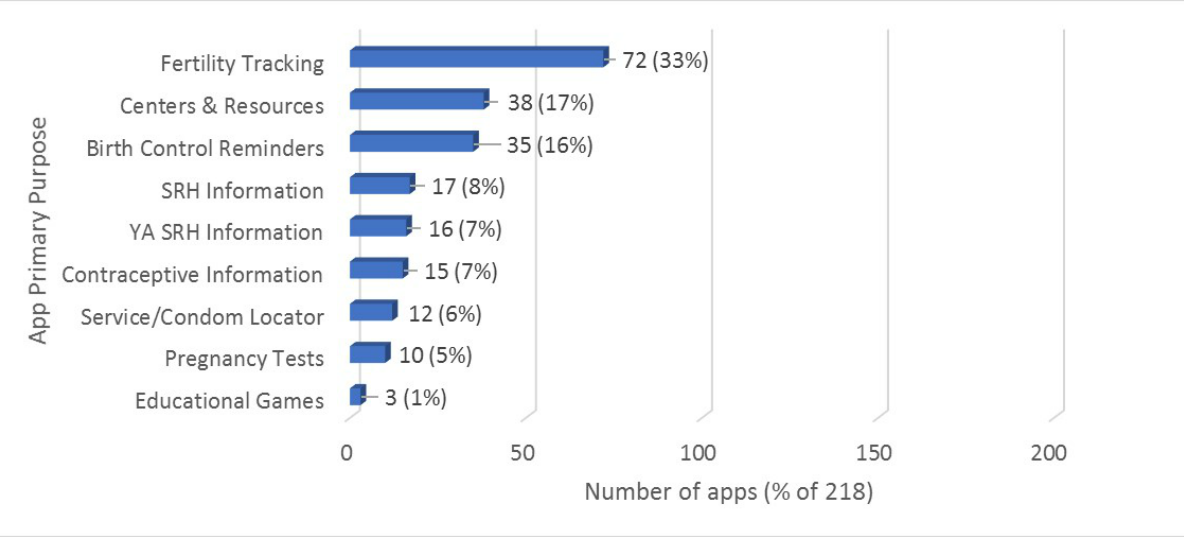
Figure 2. Primary purposes of 218 apps that support unintended pregnancy prevention.